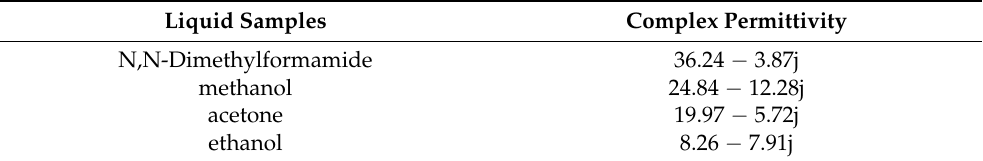
Table 2. The complex permittivity of the LUTs.